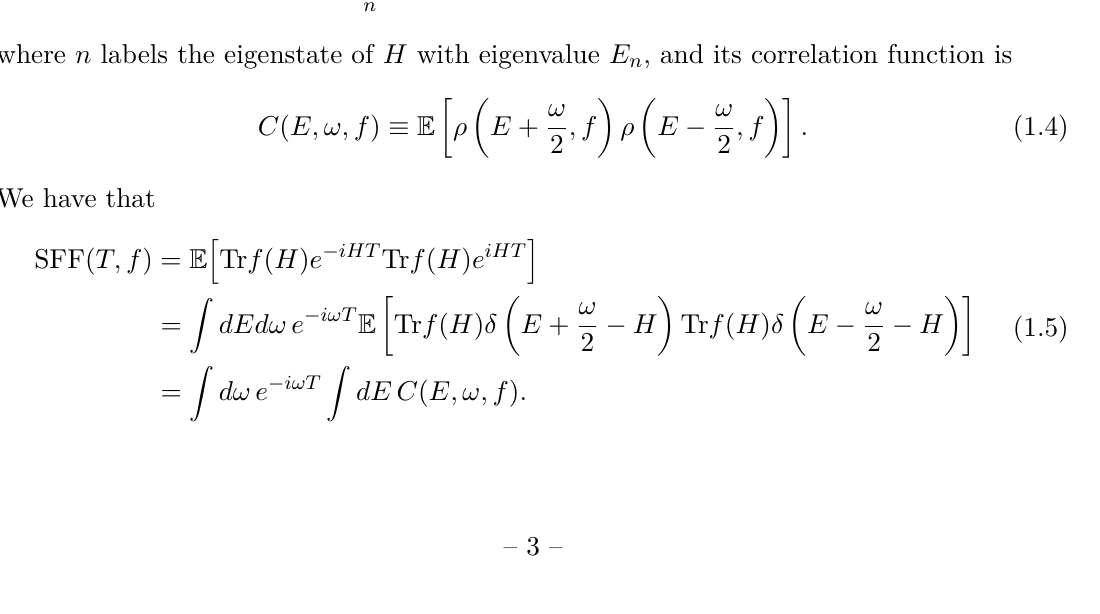
One common choice is f ( H ) = e − βH [29, 36], and another is f ( H ) = e − c ( H − E 0 ) 2 . The